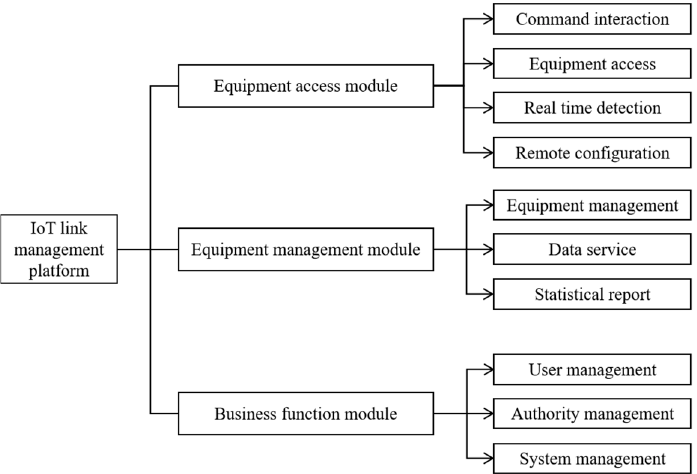
Figure 1. Overall architecture of an IoT connection management platform.